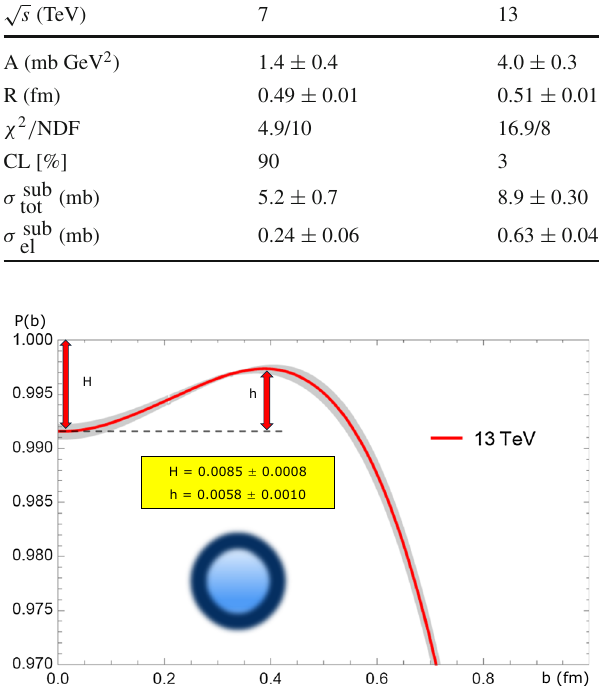
√ s , the energy dependence Fig. 5. In a limited range of